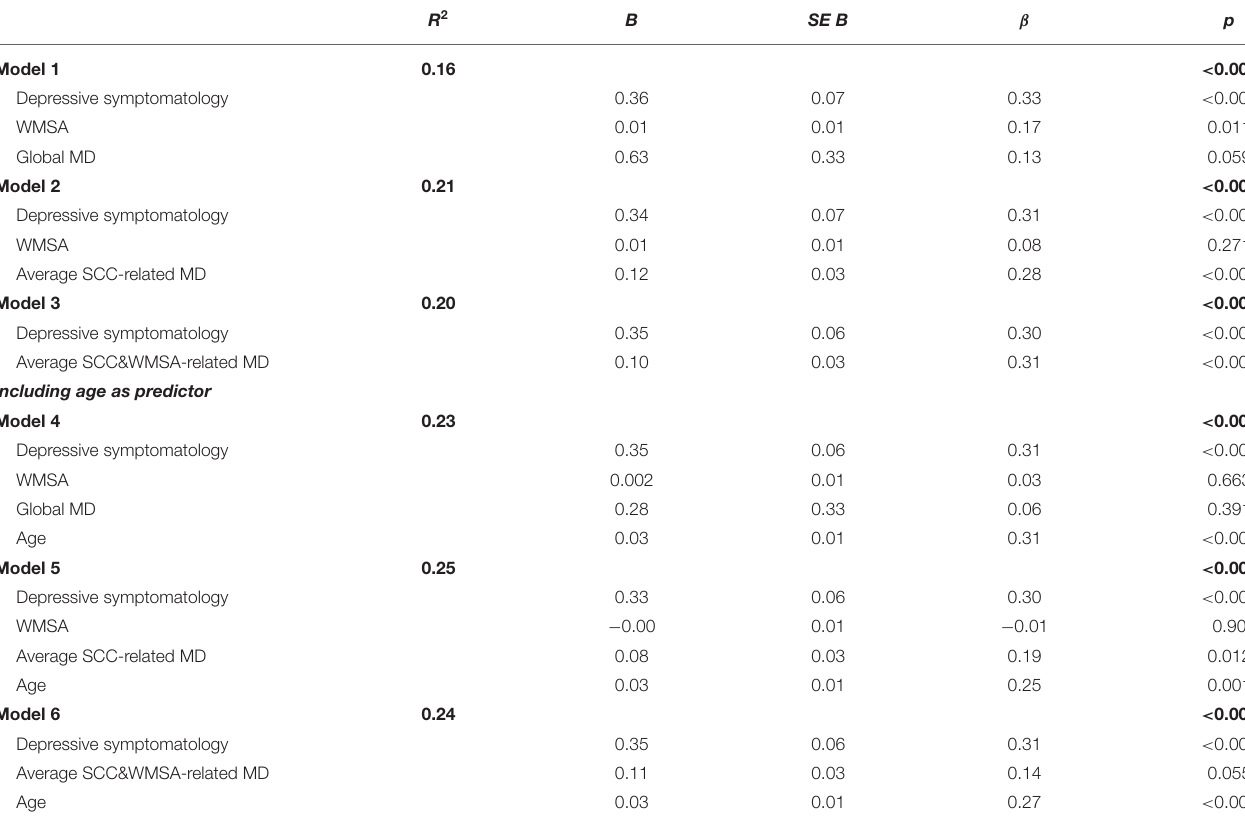
TABLE 2 | Partial association of depressive symptomatology, WMSA, MD, and age with SCC (multiple regression models).